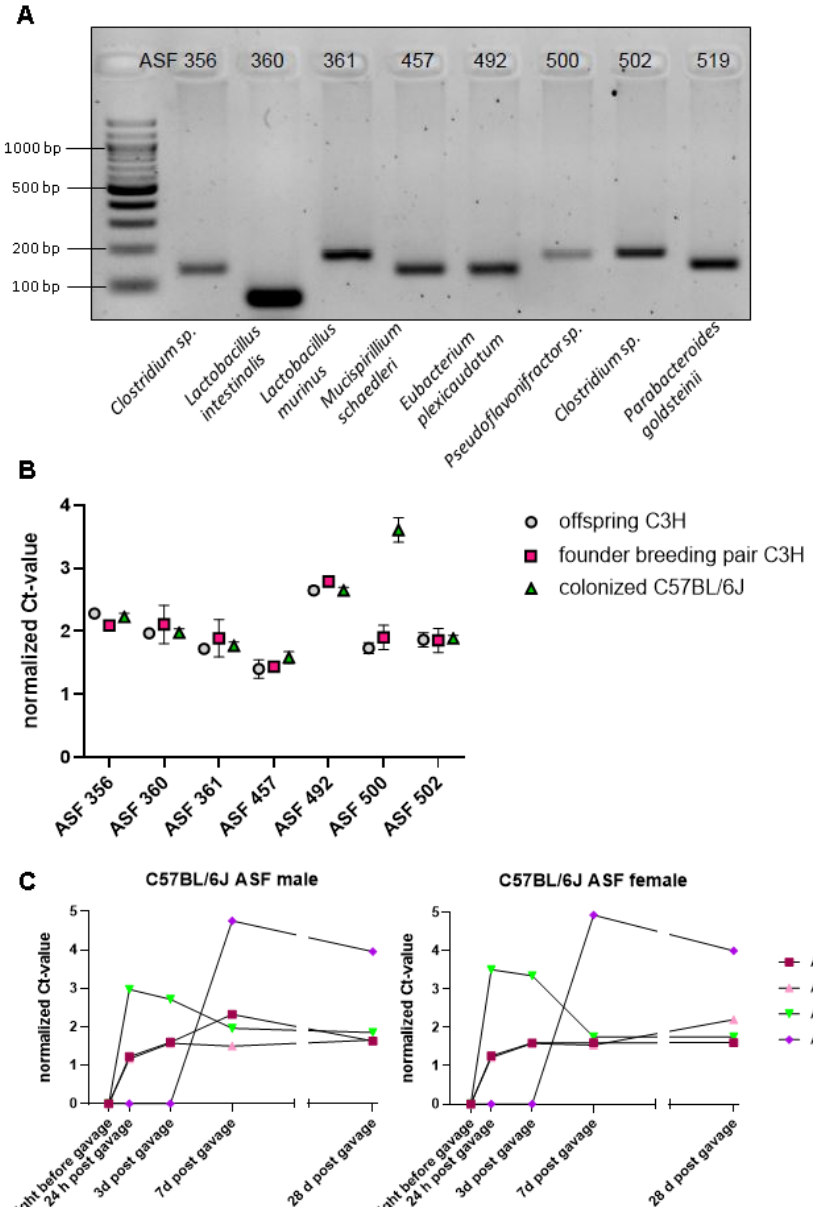
Figure 1. Transfer of ASF from C3H/HeNTac mice onto C57BL/6J mice. ( A ). PCR based detection of ASF bacteria, performed with published primer pairs [50]. All ASF-specific bacteria were detected. ( B ). qRT-PCR based detection of ASF bacteria, performed with published primer pairs [50]. The graph compares the founder breeding pair (C3H/HeNTac; aged 20 weeks; pink, N = 2) with the C3H/HeNTac ASF offspring (aged 4 weeks; grey, N = 4) and the newly colonized C57BL6J mice (aged 17–19 weeks; green, N = 2). ( C ). Three male and female GF C57BL/6J mice aged 13–16 weeks were colonized with fecal contents harvested from 10 week old male and female C3H/HeNTac ASF mice. Fecal samples were collected at various time points from each individual mouse (h=hour; d=day). qRT-PCR results for ASF 360, ASF 361, ASF 457, and ASF 492 at different time points during colonization are shown for male and female C57BL/6J mice. Data are expressed as means ± SEM.